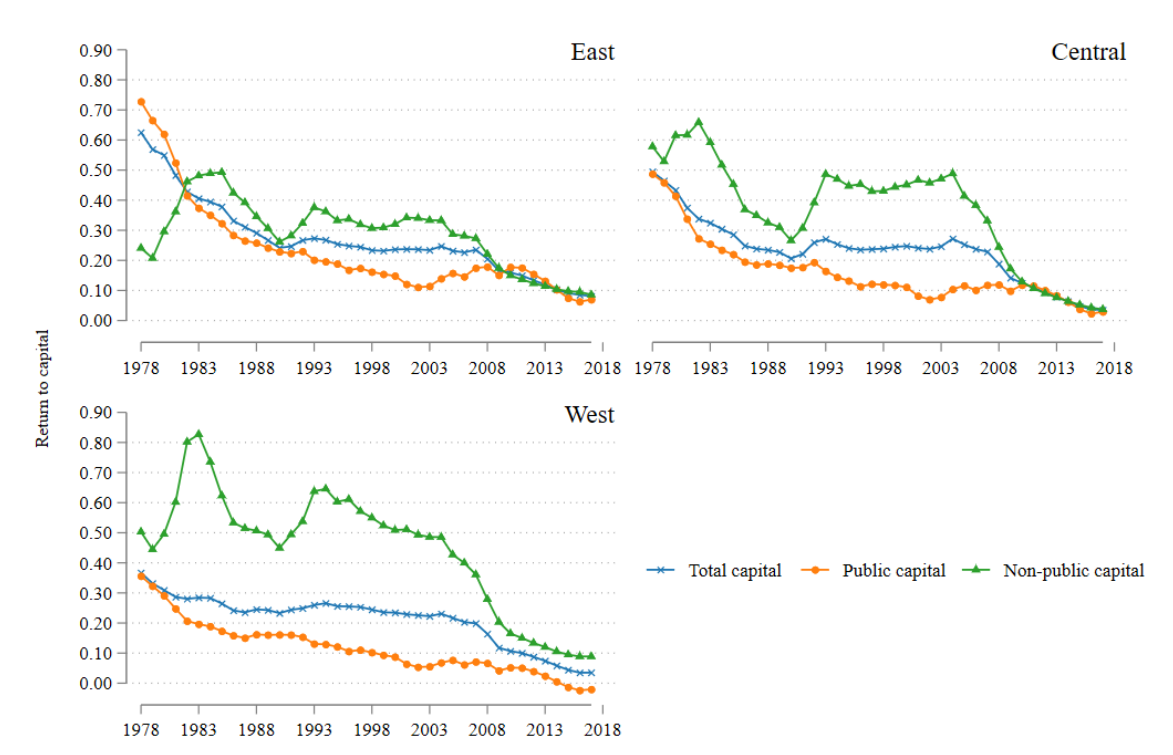
Figure 10. Return to capital in eastern, central, and western regions.